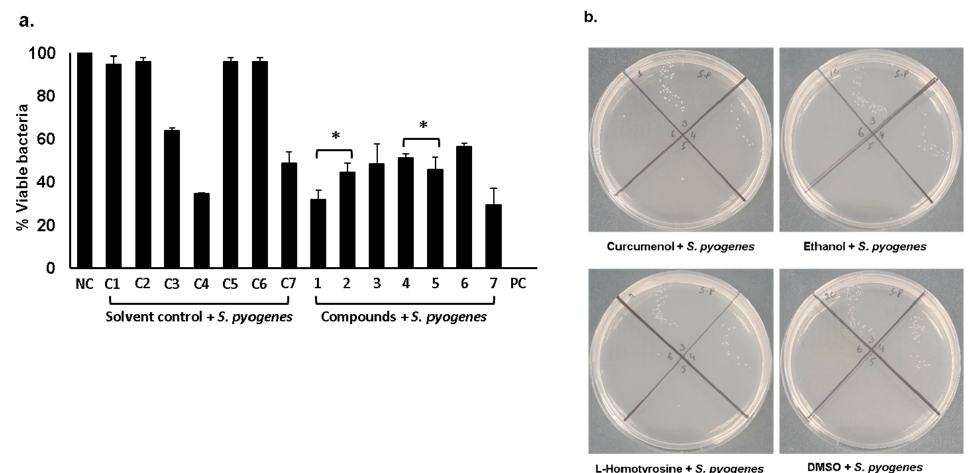
Figure 1. Antibacterial assays of pure compounds against P. aeruginosa. Briefly, 50 µg/mL of each compound was incubated with 1 × 10 6 bacteria at 37 ◦ C for 2 h. Next, cultures were serially diluted and plated onto agar plates. Following this incubation, viable bacterial colonies were counted and c.f.u. was recorded. ( a ) Bactericidal activities of curcamenol, L-homotyrosine and docosanedioic acid against P. aeruginosa. ( b ) Representative e ff ects of compounds on P. aeruginosa . The data are expressed as the mean ± SE of several independent experiments performed in duplicate. P -values were determined by student’s T-test where (*) represents P < 0.05 using GraphPad Prism 8.0.2.